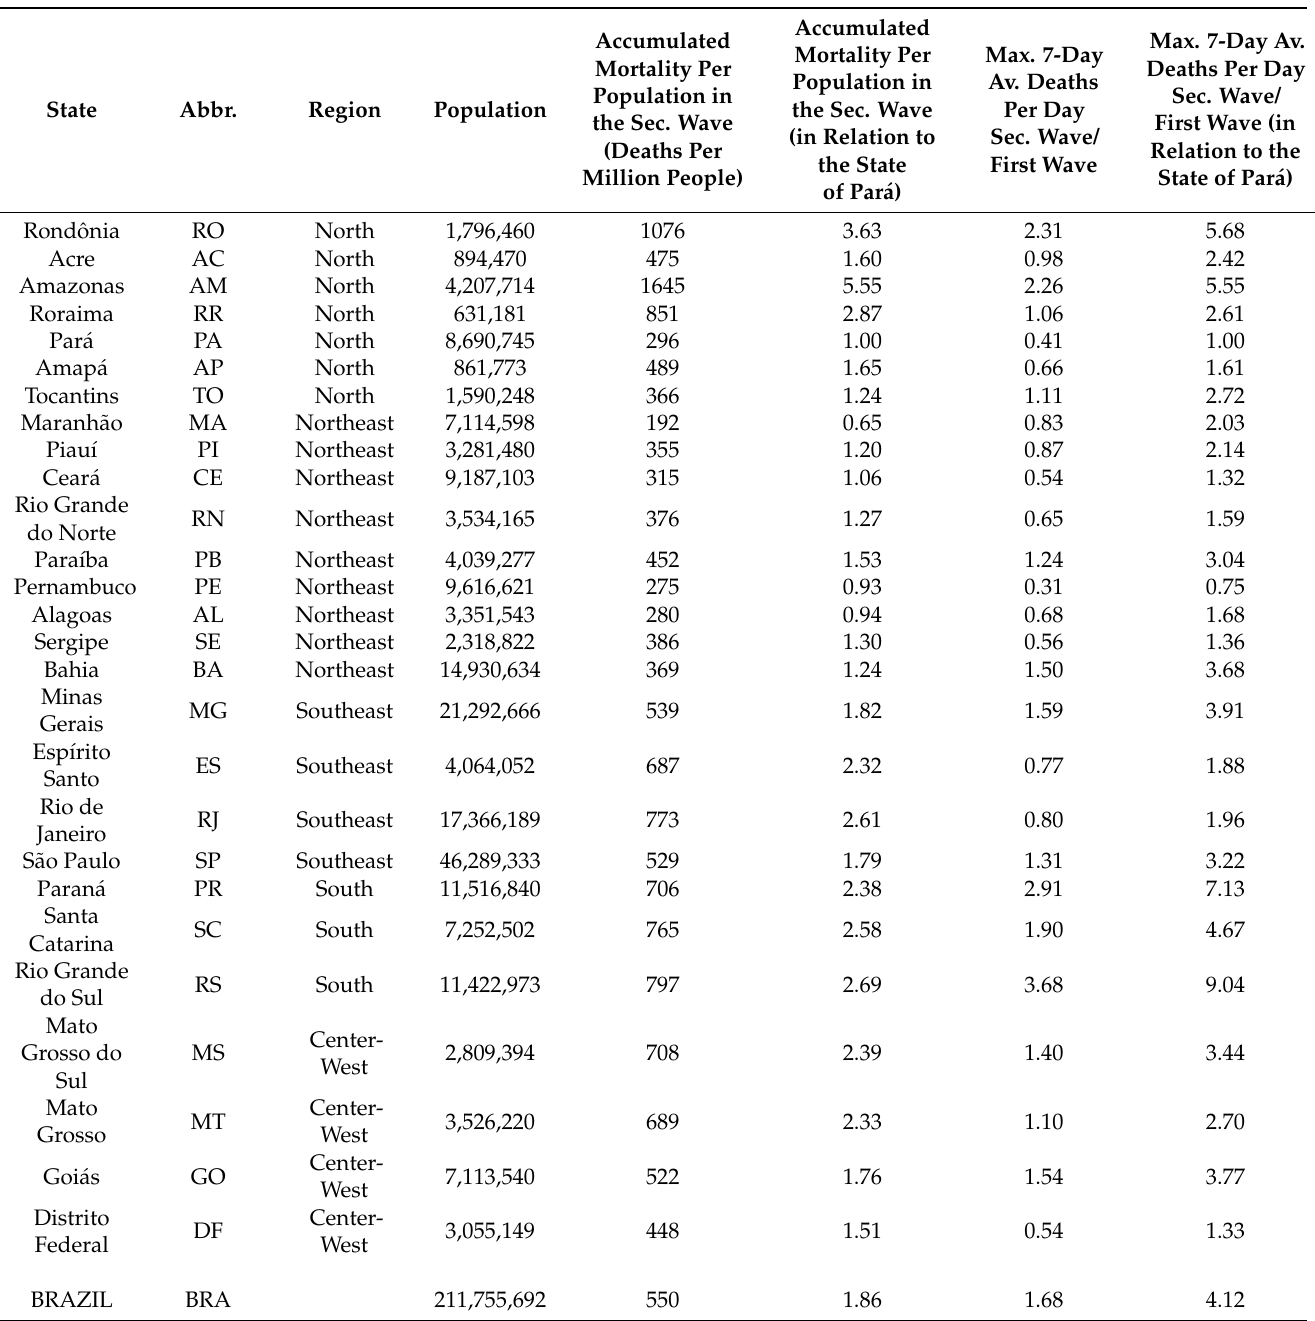
Table 1. Accumulated mortalities per population in the second wave of COVID-19 outbreak (from 11 November 2020 to 15 March 2021); and the ratios between the maximums of the 7-day average daily deaths in the second wave and in the first wave (from 1 March 2020 to 10 November 2021)—for all states of Brazil—in absolute values and in relation to the state of Par á